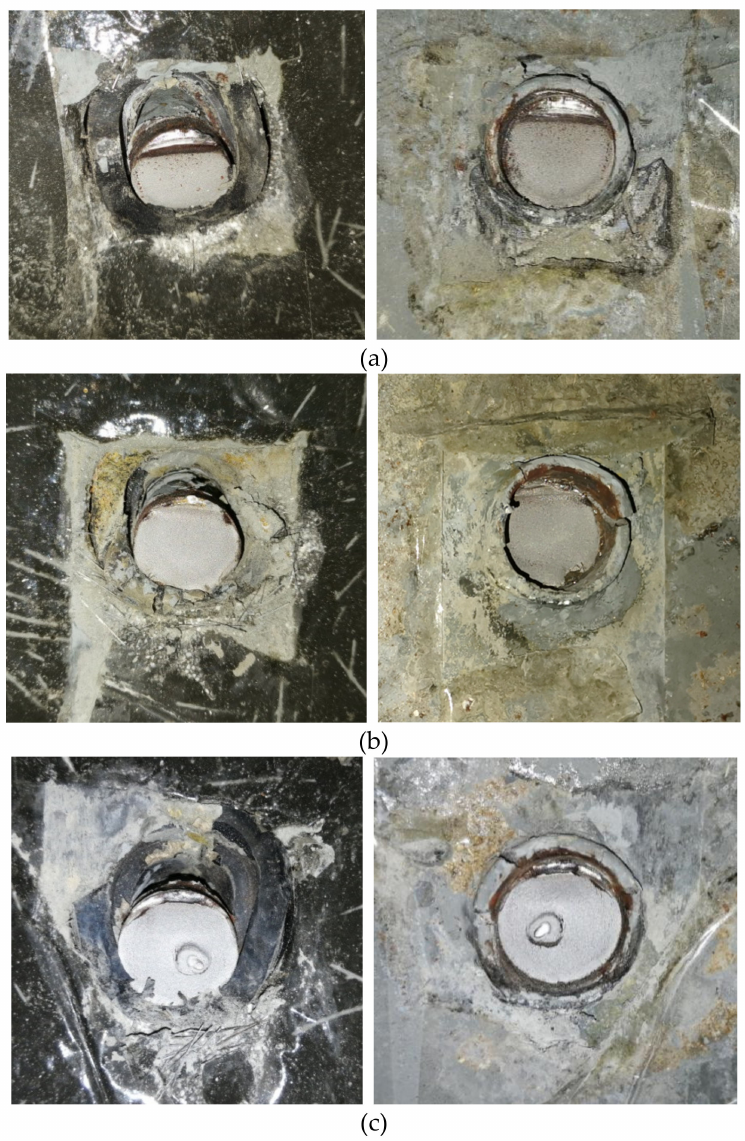
Figure 14. Fatigue failure modes: ( a ) RS25-50-U; ( b ) RS25-70-U; ( c )